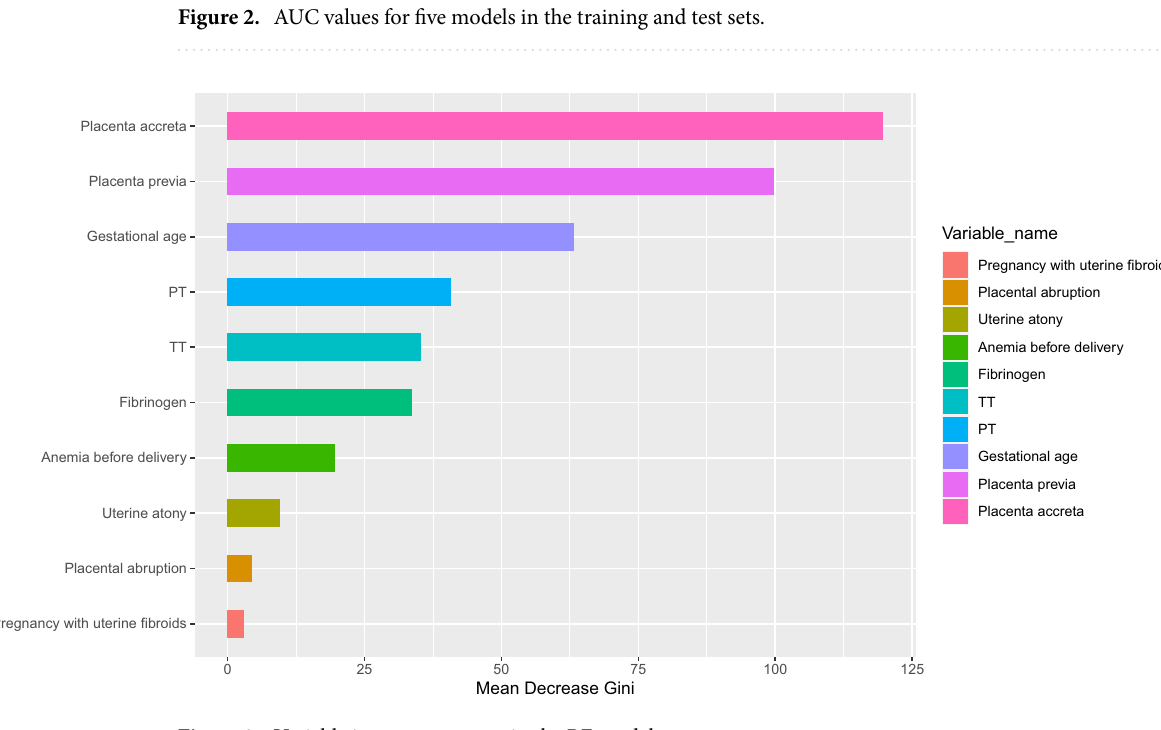
Figure 3. Variable importance score in the RF